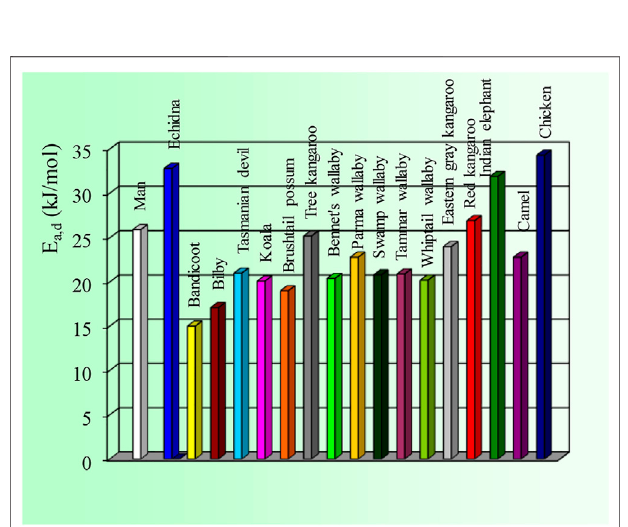
FIGURE5| Valuesoftheactivationenergyofwaterdiffusionthroughthe RBC membrane of man and several animal species. The SD values are: Man: 2.9;Echidna:6.2;AllMarsupials:1.9 – 2.0;Elephant:0.6:Camel:1,8:Chicken: 7.0. The original results were published previously (Benga et al., 1992b; BengaandBorza,1995;Bengaetal.,1999;Bengaetal.,2000a;Bengaetal., 2003; Benga et al., 2010a; Benga et al., 2010b; Benga, 2013; Benga et al., 2015).